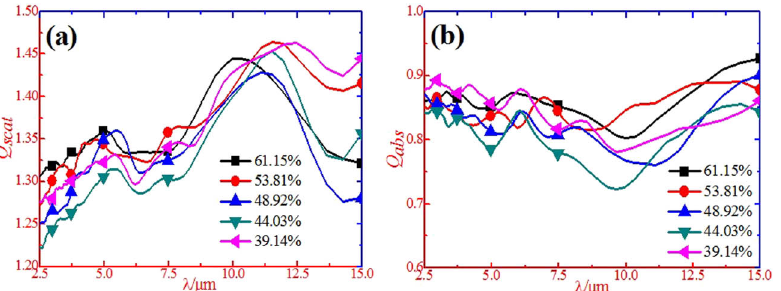
Figure 2: Analytical results of ( a ) scattering factor and ( b ) absorption factor with respect to various nano fi ber contents of 61.15%, 53.81%, 48.92%, 44.03% and